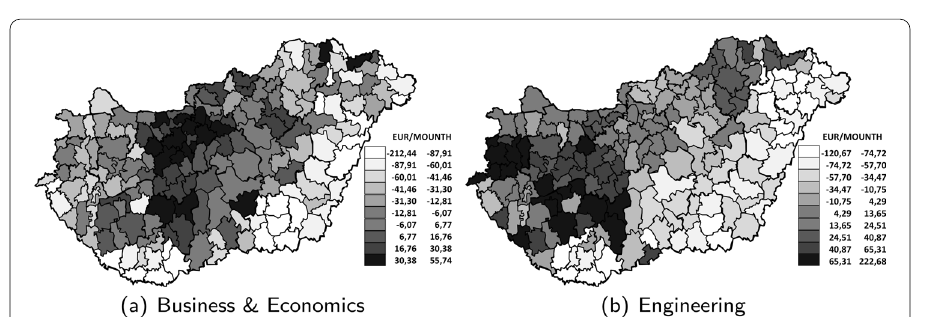
Fig. 5 Added value of locations to salaries (10